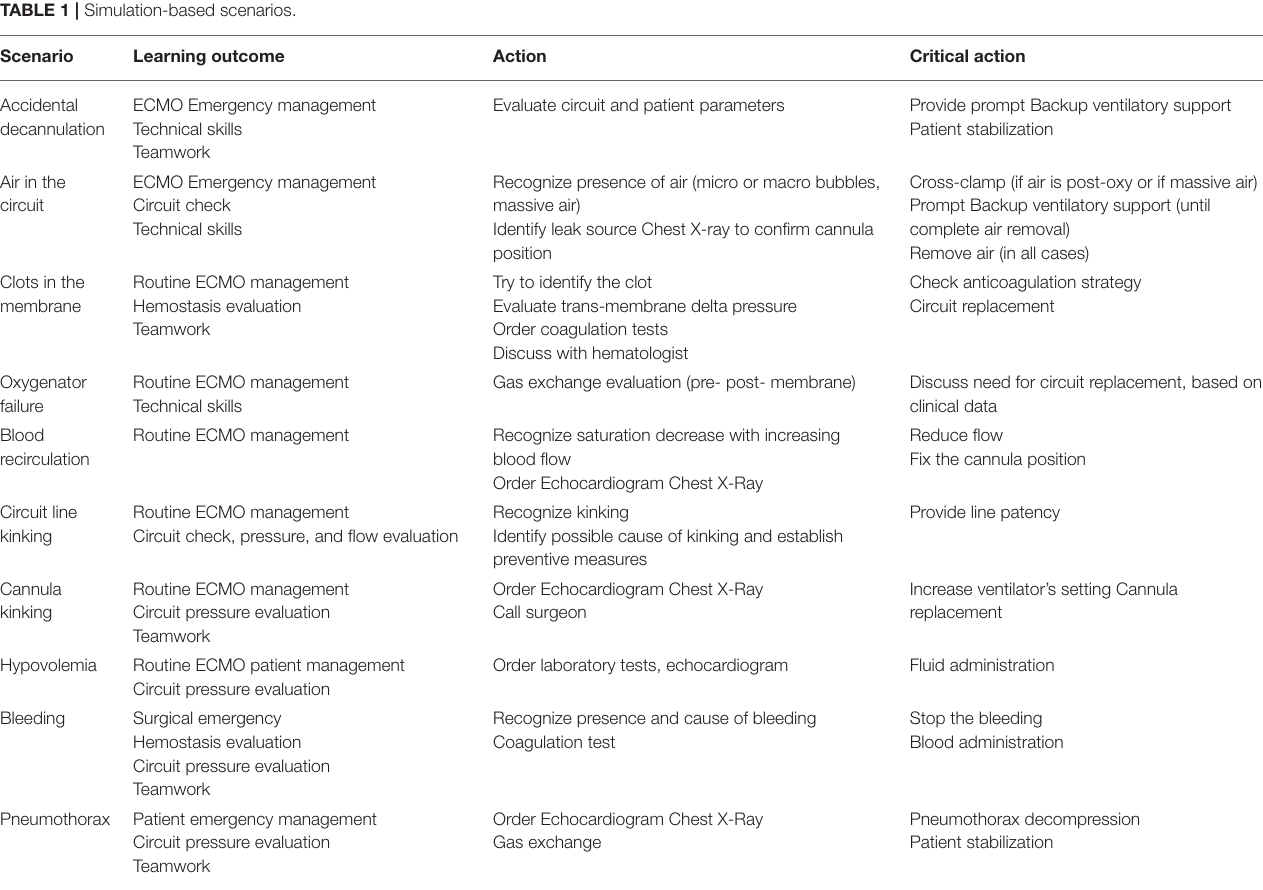
TABLE 1 | Simulation-based